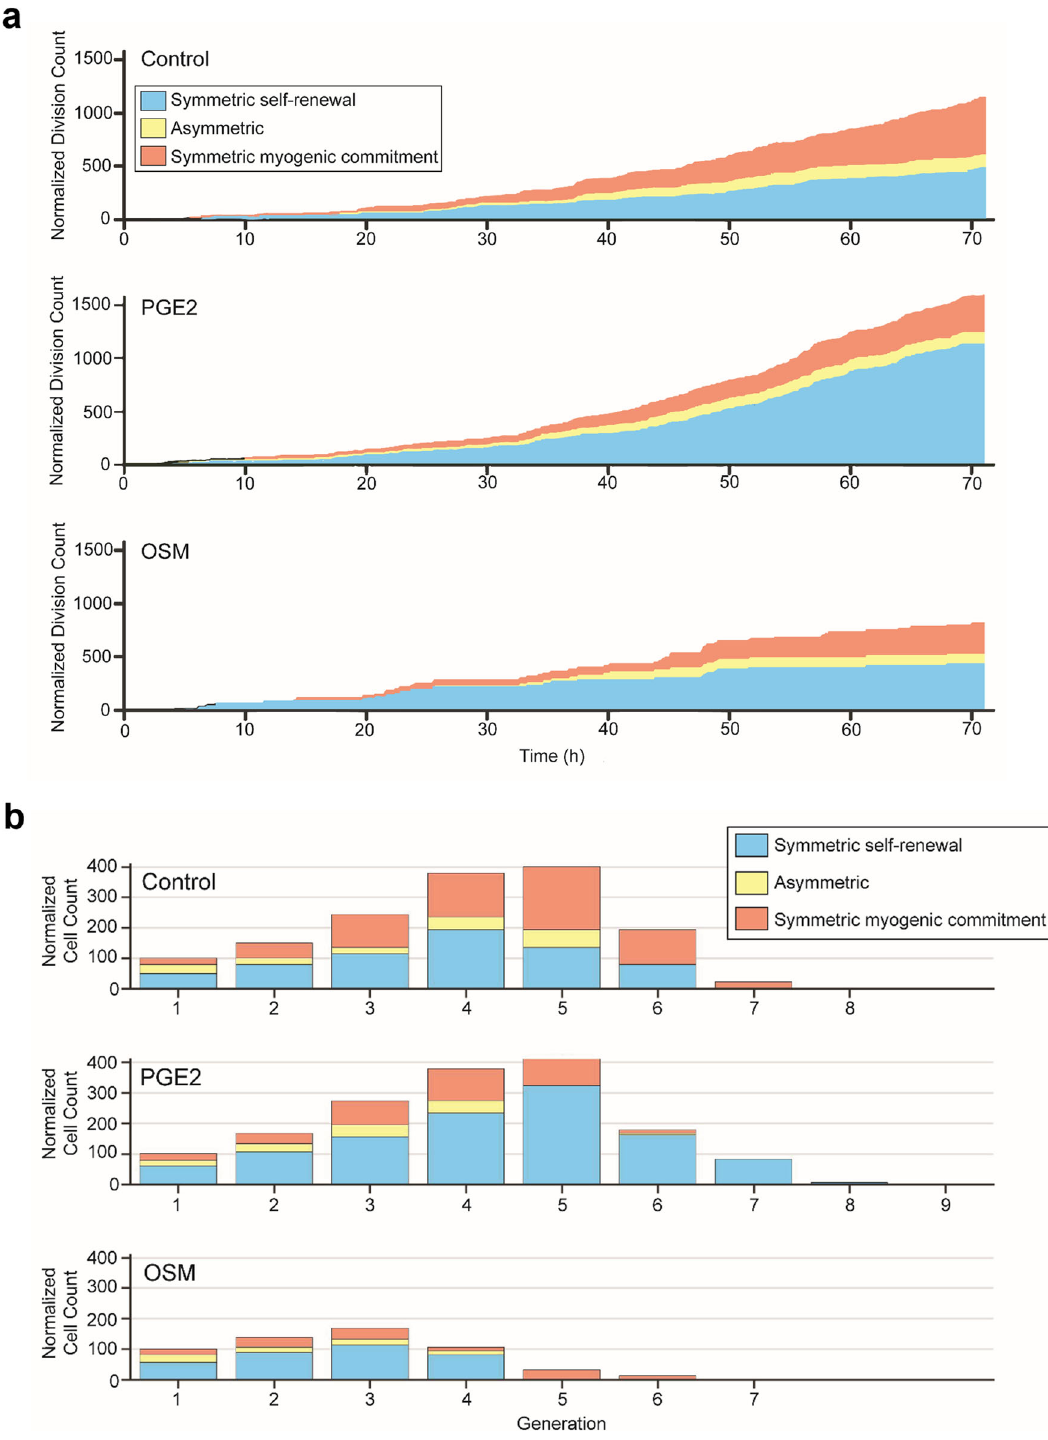
Fig. 4 Machine learning-based division classi fi cation reveals cell fate dynamics. a Cumulative division counts and classi fi cations for vehicle, PGE2, and OSM treated MuSCs, normalized to represent the same number of starting clones per condition. b Classi fi cation of division types broken down by generation reveals temporal dynamics of cell fate decisions. To enable comparisons across conditions, the number of initial clones was normalized to be 100 in each condition. At least 18 independent clones were tracked for each condition from at least two independent experimental